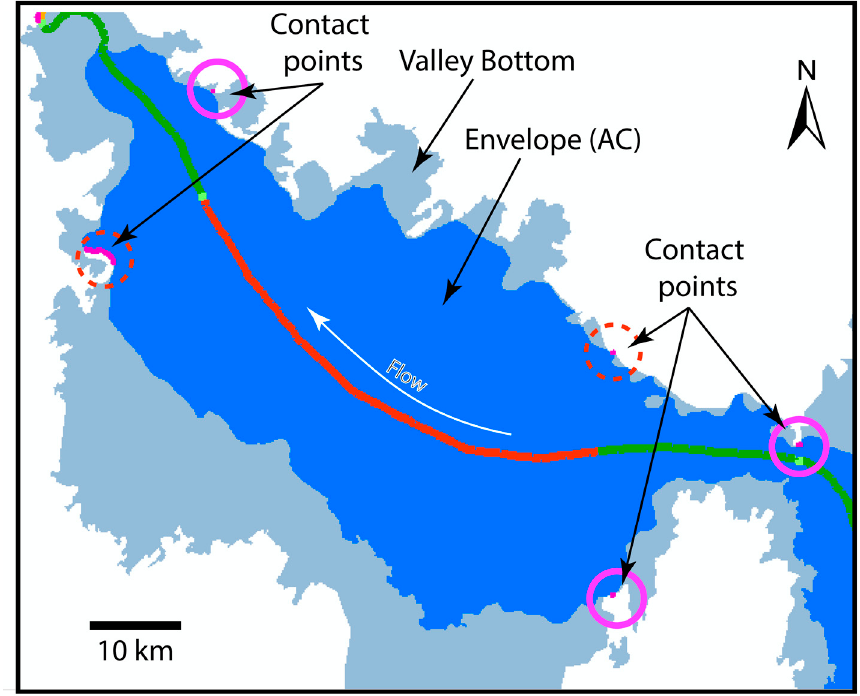
Figure 5. Inconsistent output from O’Brien et al. [6] algorithm, which reports a long river stretch as “confined” (red axis; green represents “laterally unconfined”, instead) while in reality it only presents two small contact points (small red dotted circles), one at its beginning (top, right, corresponding to the beginning of the red stretch) and one at its end (bottom, left). The blue area is the envelope of the Active Channels (AC) that in this particular case cover a very wide area as the river is anastomosed. The pale blue-grey area is the valley bottom.